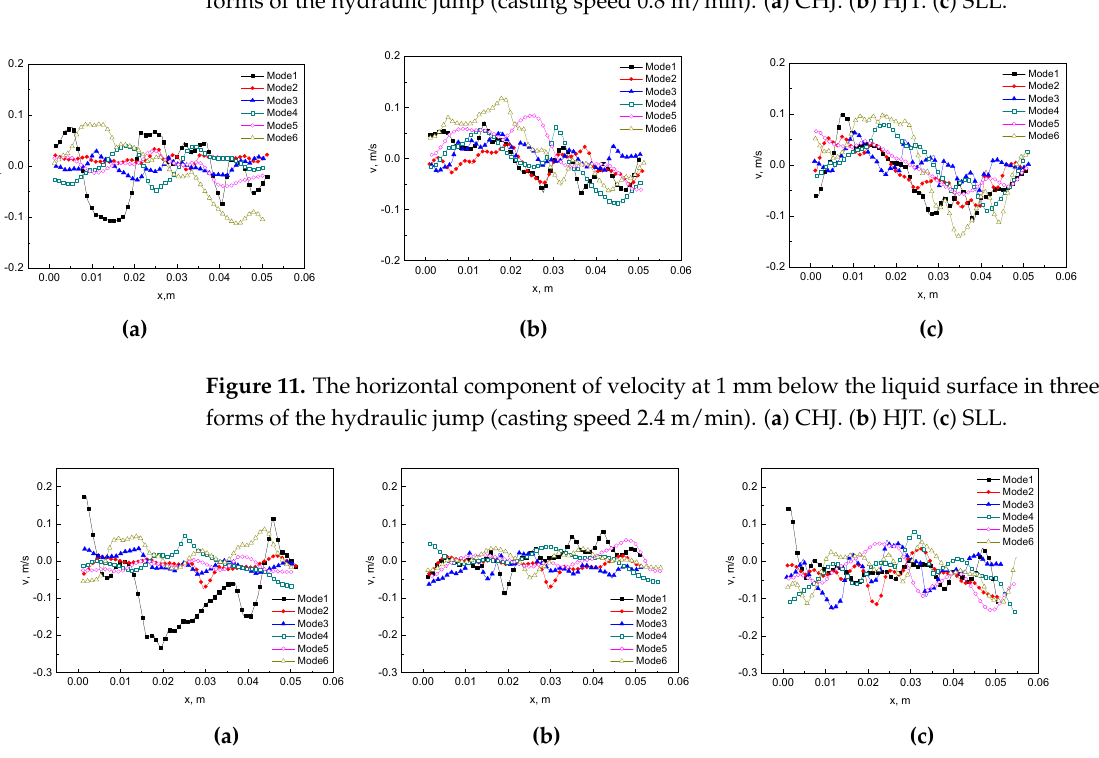
Figure 12. The vertical component of velocity at 1 mm below the liquid surface in three physical forms of the hydraulic jump (casting speed 2.4 m/min). ( a ) CHJ. ( b ) HJT. ( c ) SLL